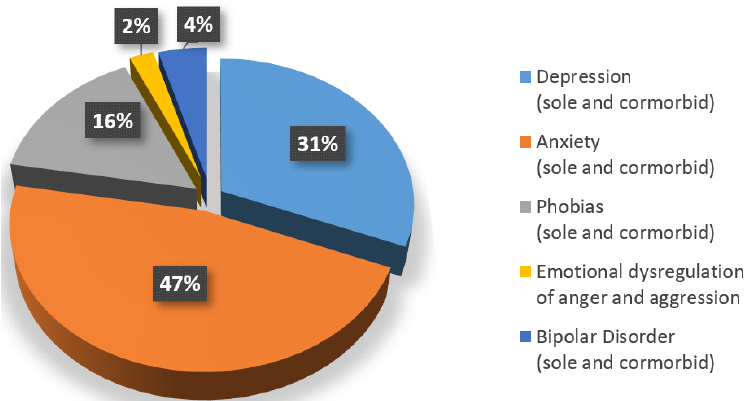
Figure 2. Distribution of affective disorders that were investigated by the selected